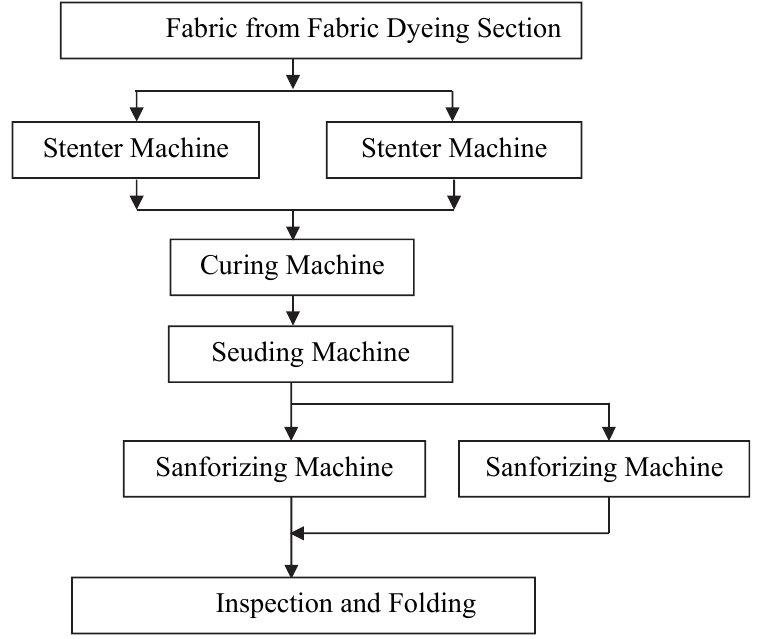
Fabric from Fabric Dyeing